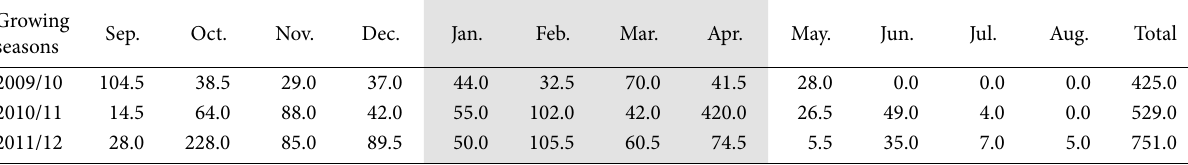
Table 1. Monthly rainfall (mm) recorded during the experimental period. The critical period for pathogen infection and disease develop- ment is highlighted in gray. Growing seasons